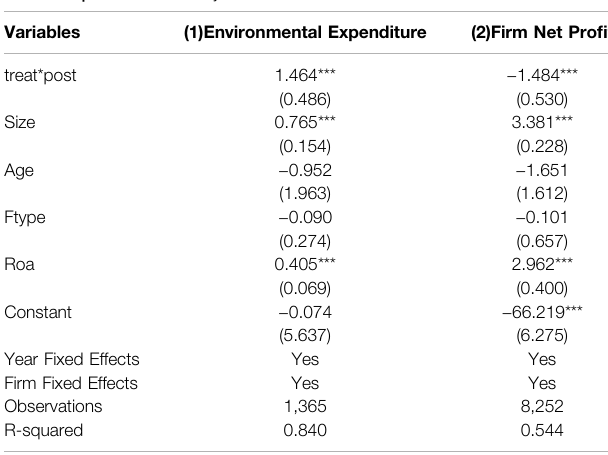
TABLE 6 | Mechanism